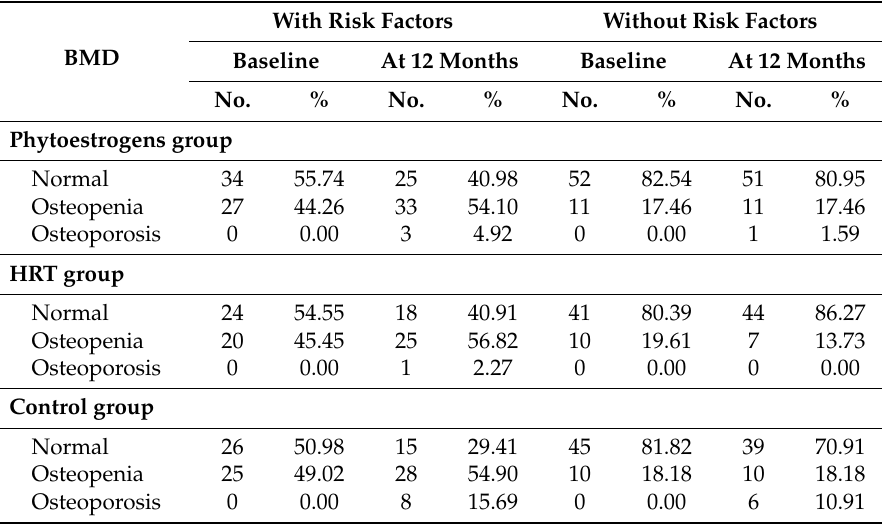
Table 5. Evolution of cases according to T-score and risk